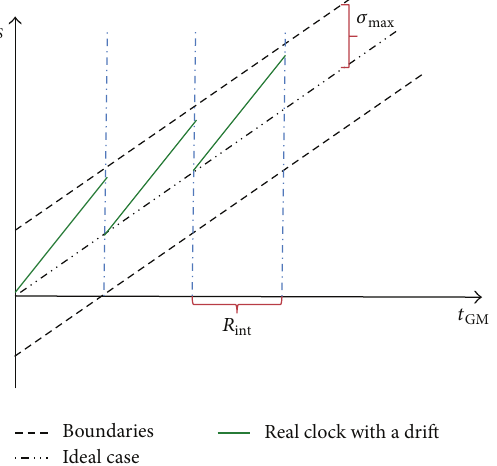
Figure 1: Periodic correction of slave clock time, 𝑡 𝑆 , according to grandmaster clock time, 𝑡 GM